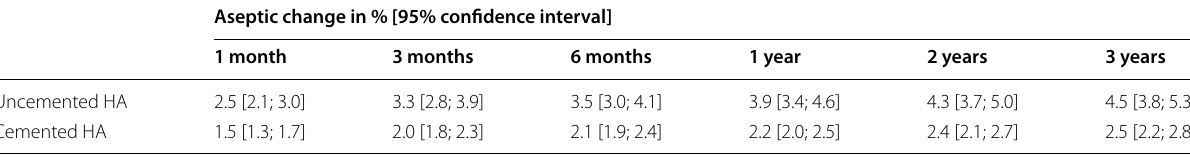
Table 2 Percentage of aseptic revisions after femoral neck fracture treated with cemented and uncemented hemiarthroplasty Aseptic change in % [95% confidence interval]